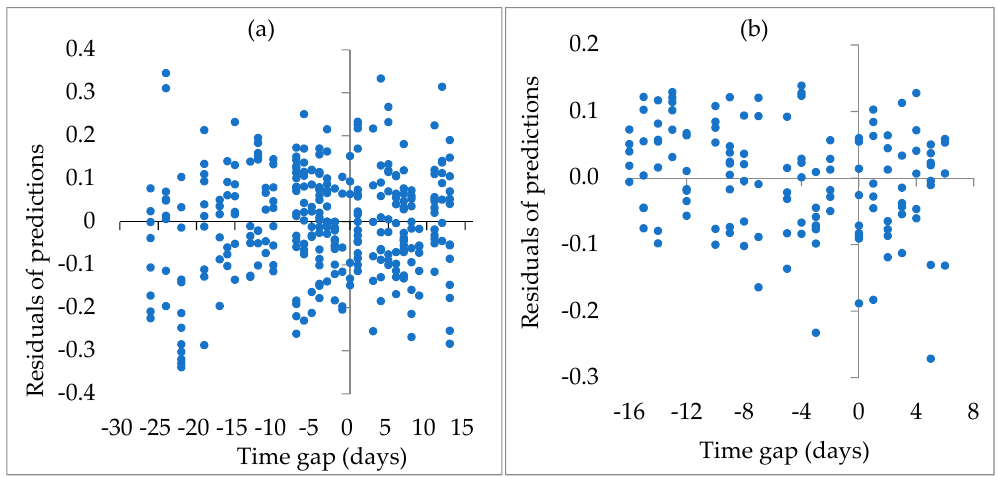
Figure 15. The residuals of predictions from Opt_kNN graphed against the time gap of the field survey date from the image acquisition date for ( a ) Duolun and ( b ) Kangbao (The time gaps were represented using negative numbers if the field survey was conducted before the image acquisition and otherwise using positive numbers).